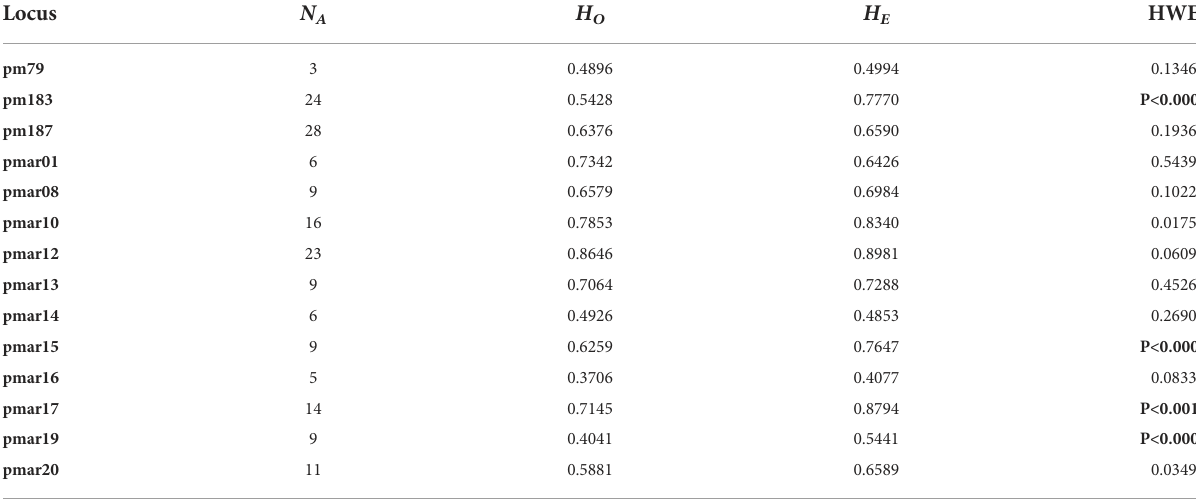
TABLE 2 Pachygrapsus marmoratus microsatellites genetic variability and Hardy-Weinberg equilibrium. Locus